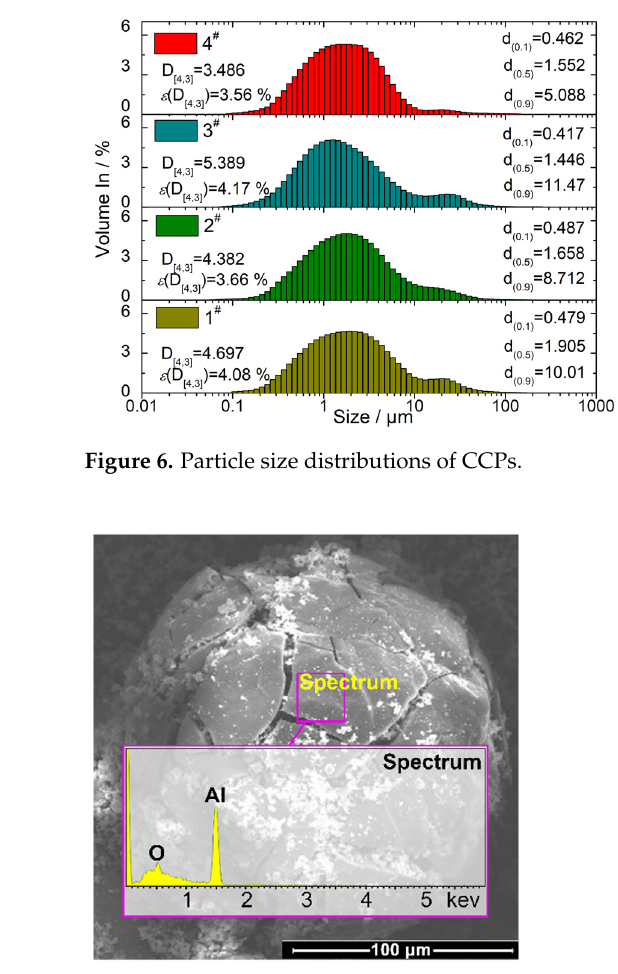
Figure 6. Particle size distributions of CCPs.